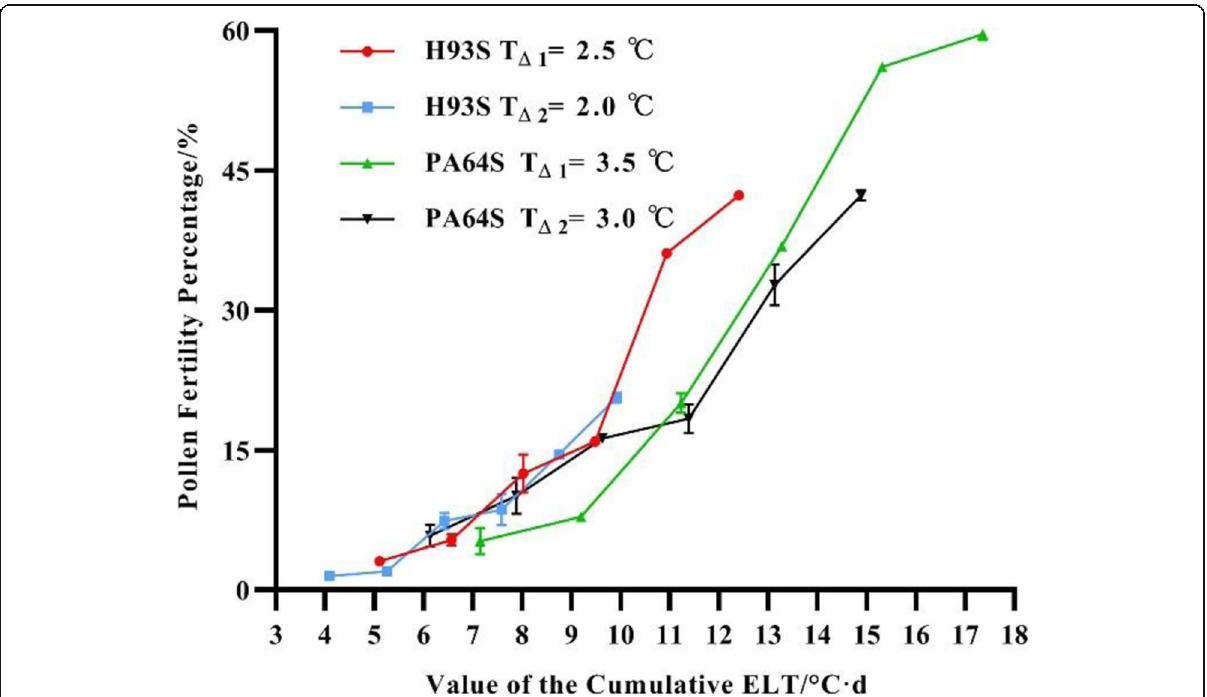
Fig. 1 Pollen fertility percentage of H93S and PA64S after 7 d of treatment under different Σ T Δ conditions. The actual data for all the Σ T Δ values are shown in Table 3